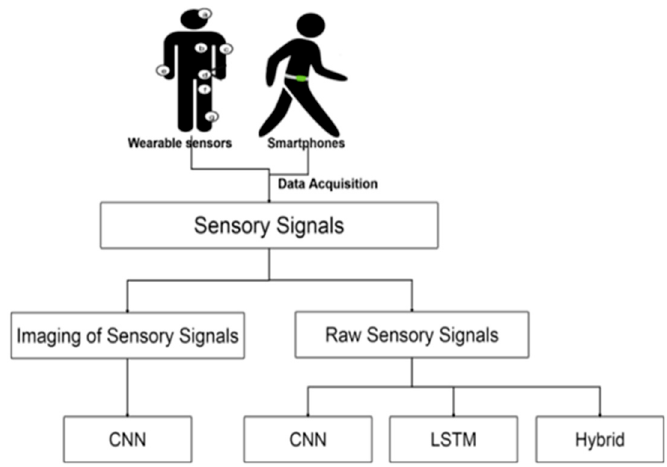
Figure 1. Categorization of proposed deep-learning models [5].